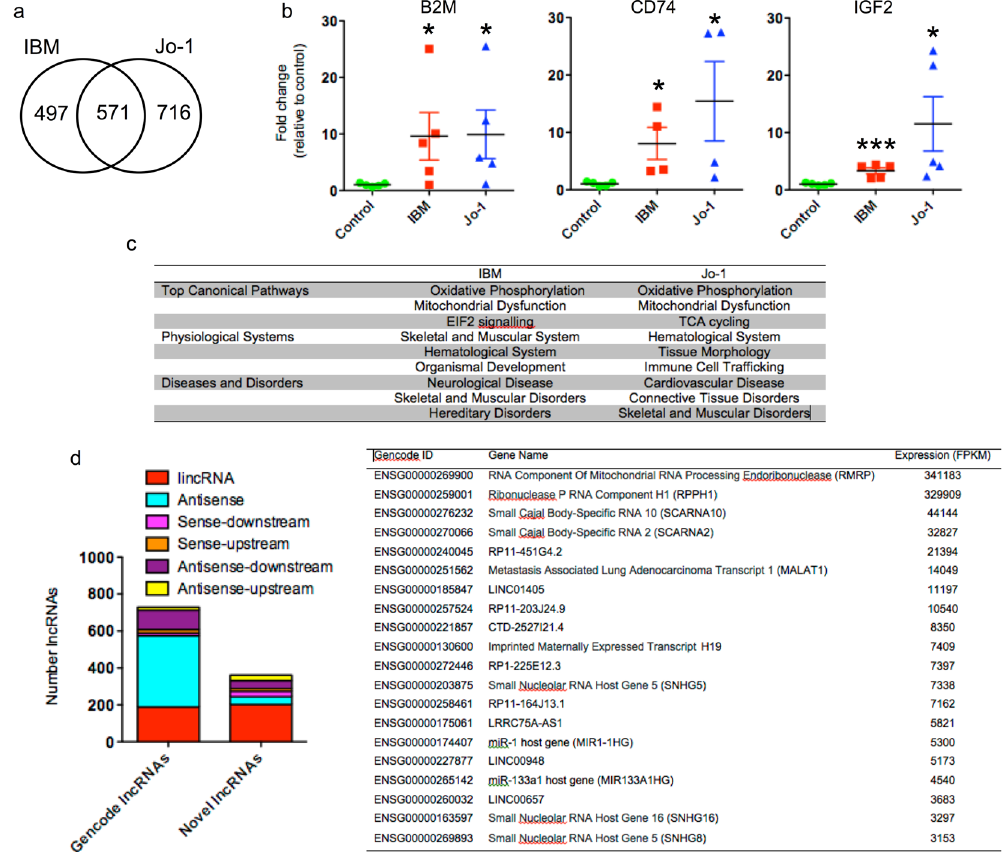
Figure 2. Analysis of mRNA and lncRNA expression data in control, IBM and Jo-1 myositis. ( a ) Venn diagram showing overlap between differentially expressed mRNAs in IBM and Jo-1 myositis, ( b ) Changes in levels of β 2 - microglobulin (B2M), CD74 and IGF2 mRNA expression were confirmed by qRT-PCR. The data are presented as the mean ± SEM of 4–5 patients where * p < 0.05 and *** p < 0.001 (Mann-Whitney U-test). ( c ) Pathway analysis of differentially expressed mRNAs in IBM and Jo-1 myositis, ( d ) Classification of Gencode and novel lncRNA in skeletal muscle and, ( e ) List of most highly expressed lncRNA in control skeletal